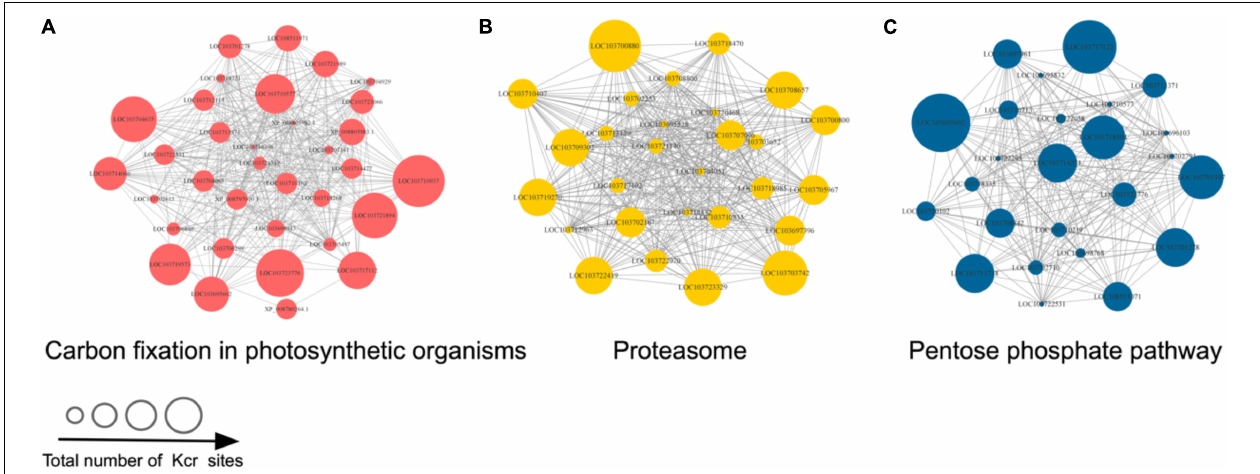
FIGURE 5 | The three KEGG pathways with the highest score in the protein–protein interaction (PPI) networks of Kcr proteins in D. huoshanense . The network of Kcr protein interactions was visualized by using Cytoscape (listed with protein ID names). (A) Carbon fixation in photosynthetic organisms. (B) Proteasome. (C) Pentose phosphate pathway. The size of the dots represents the number of Kcr sites in each network.